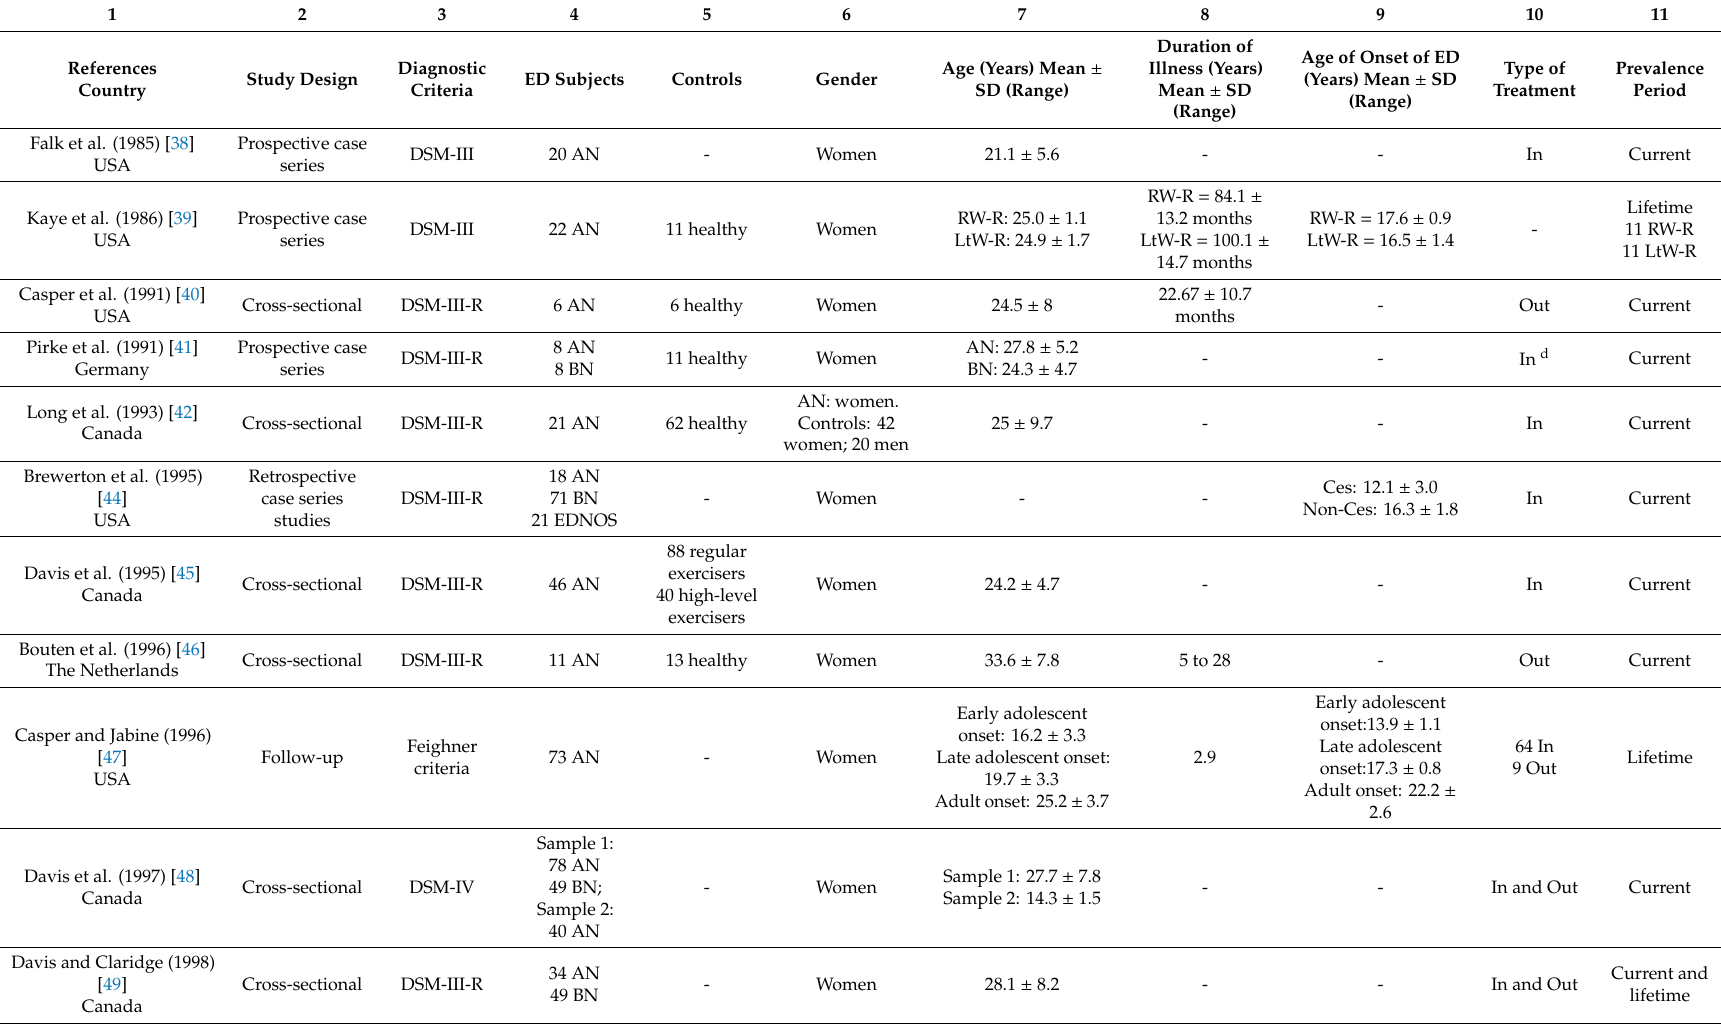
Table 3. Methods of studies investigating problematic use of physical activity in ED (columns 1 to